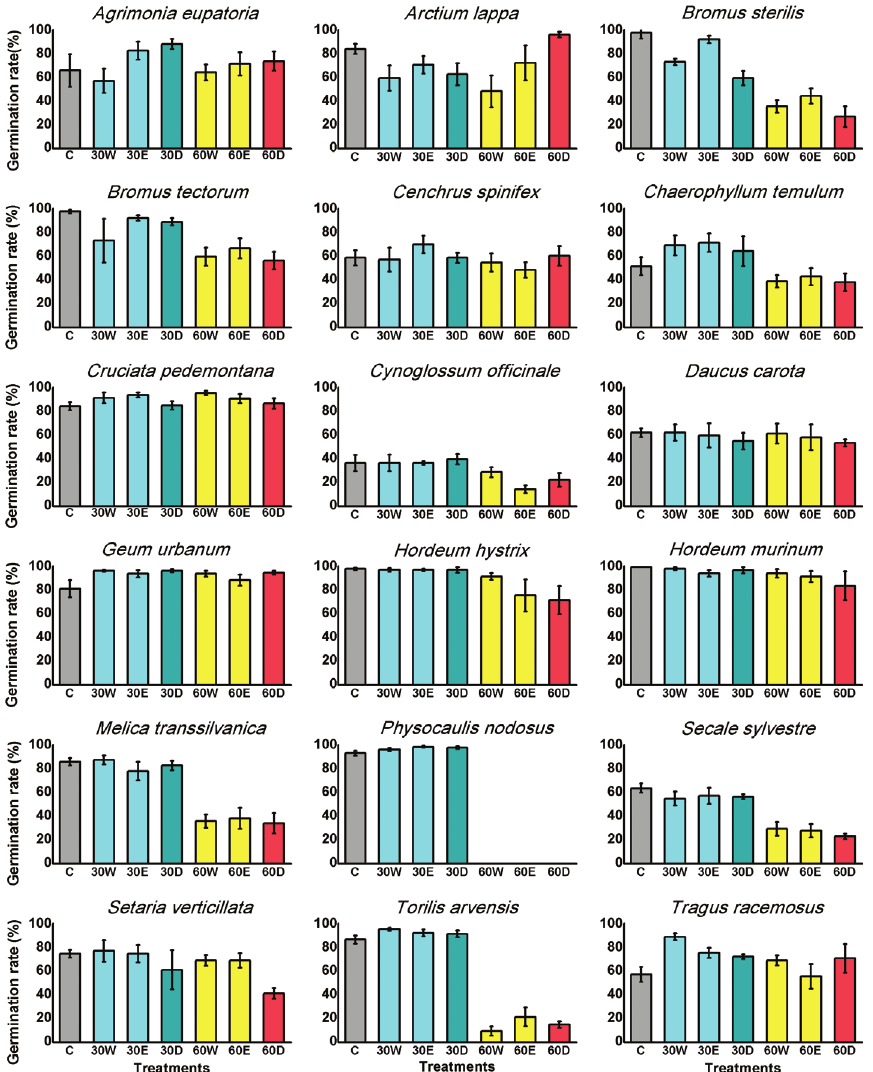
Figure 1. Germination rate (%, mean ± SE) in the control and the six washing treatments. Notations: grey column, C – control; blue columns: gentle washing at 30 °C (30W – washing with water at 30 °C, 30E – washing with eco-friendly soap nut at 30 °C and 30D – washing with detergent at 30 °C); yellow and orange columns – intense washing at 60 °C (60W – washing with water at 60 °C, 60E – washing with eco- friendly soap nut at 60 °C and 60D – washing with detergent at 60 °C). Germination rate is expressed as the percentage of sown propagules that germinated in a treatment (25 propagules were sown in five replicates per treatment except for H. murinum , where 25 propagules were sown in three replicates per